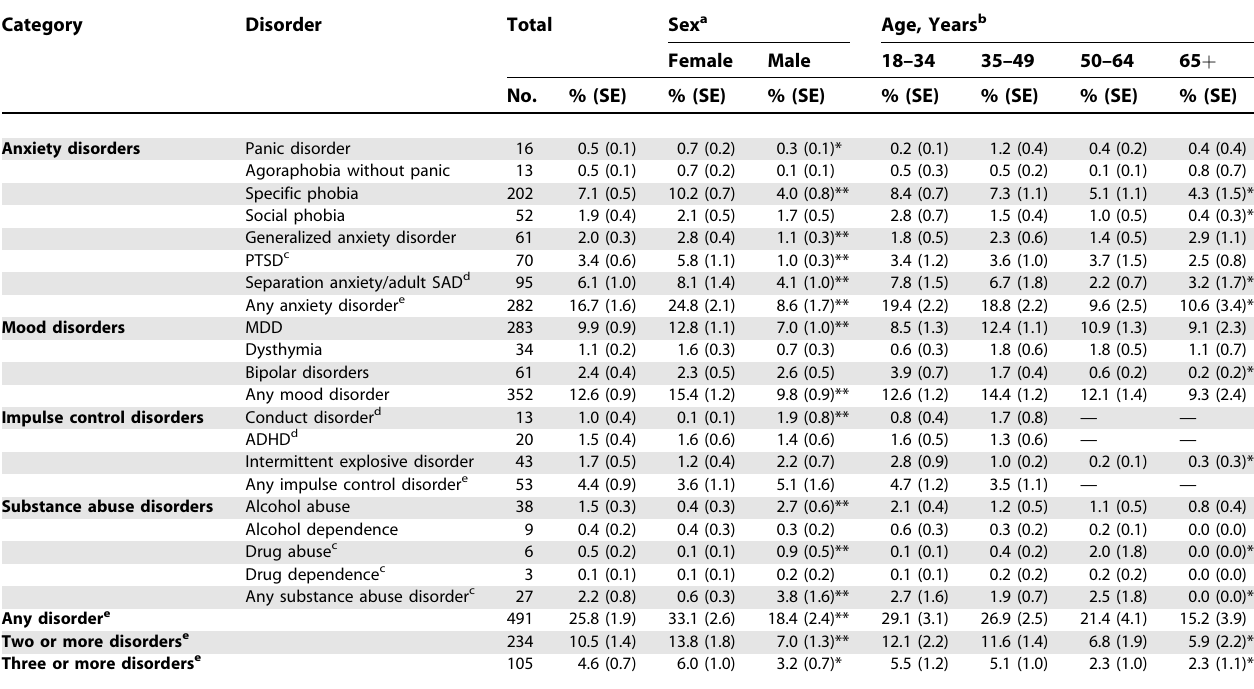
Table 1. Lifetime Prevalence of Mental Disorders and Age